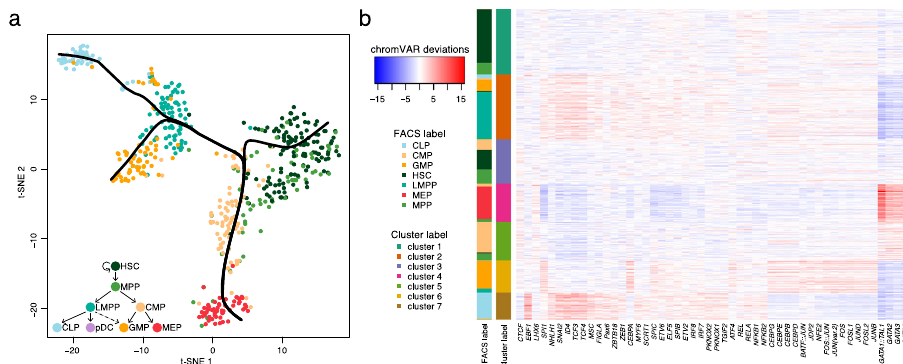
Fig. 5 Trajectory inference and motif enrichment analysis. a t-SNE visualization of the cells from donor BM0828 and the inferred trajectory with Slingshot using the output of RA3 and Louvain clustering. The hematopoietic differentiation tree 29 is shown on the bottomleft. b The top 50 most variable TF binding motifs within the cluster-speci fi c peaks for the cells of donor BM0828. The deviations calculated by chromVAR are shown. FACS fl uorescent activated